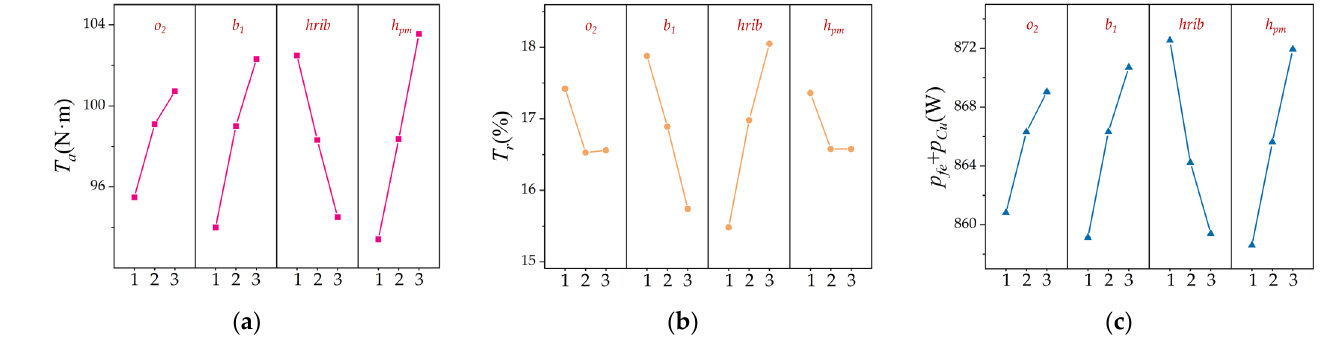
Figure 8. Impact of level values of optimization variables on optimization objectives: ( a ) impact of variable level on T a ; ( b ) impact of variable level on T r ; ( c ) impact of variable level on p fe + p Cu . The variance values and proportion of variables with respect to the optimization ob- jectives were calculated according to Equations (13) and (14) and Table 7, as shown in Table 8. Table 8. Variance values and proportion between optimization variables and optimization objec- tives.